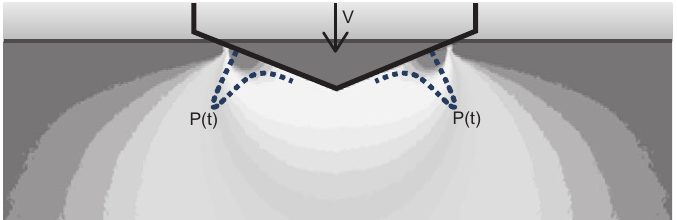
Figure 1 Wave slamming induced pressure pulse propagation along a typical wedge simulating a bow